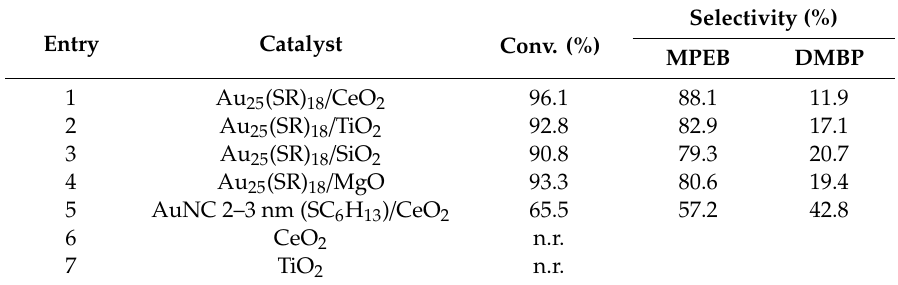
Table 4. The catalytic performance of Au 25 (SR) 18 / oxides in the Sonogashira cross-coupling reaction of p-iodoanisole and phenylacetylene. DMBP and MPEB stand for homo-coupling product of 4,4 (cid:48) -dimethoxy-1,1 (cid:48) -biphenyl and cross-coupling product of 1-methoxy-4-(2-phenylethynyl)benzene, respectively. Reaction conditions: 100 mg catalyst (1 wt % Au 25 (SR) 18 or AuNC 2–3 nm (SC 6 H 13